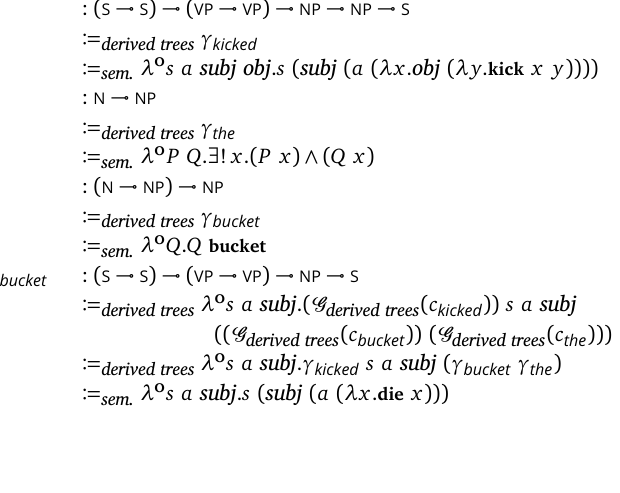
Constants of (cid:6) TAG and their interpretation by G